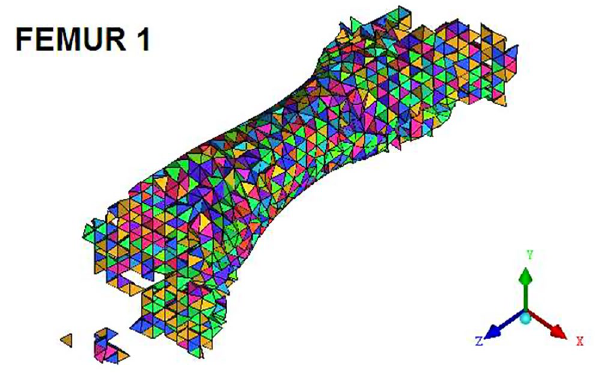
Fig. 4 Multiple material distribution in femur 1